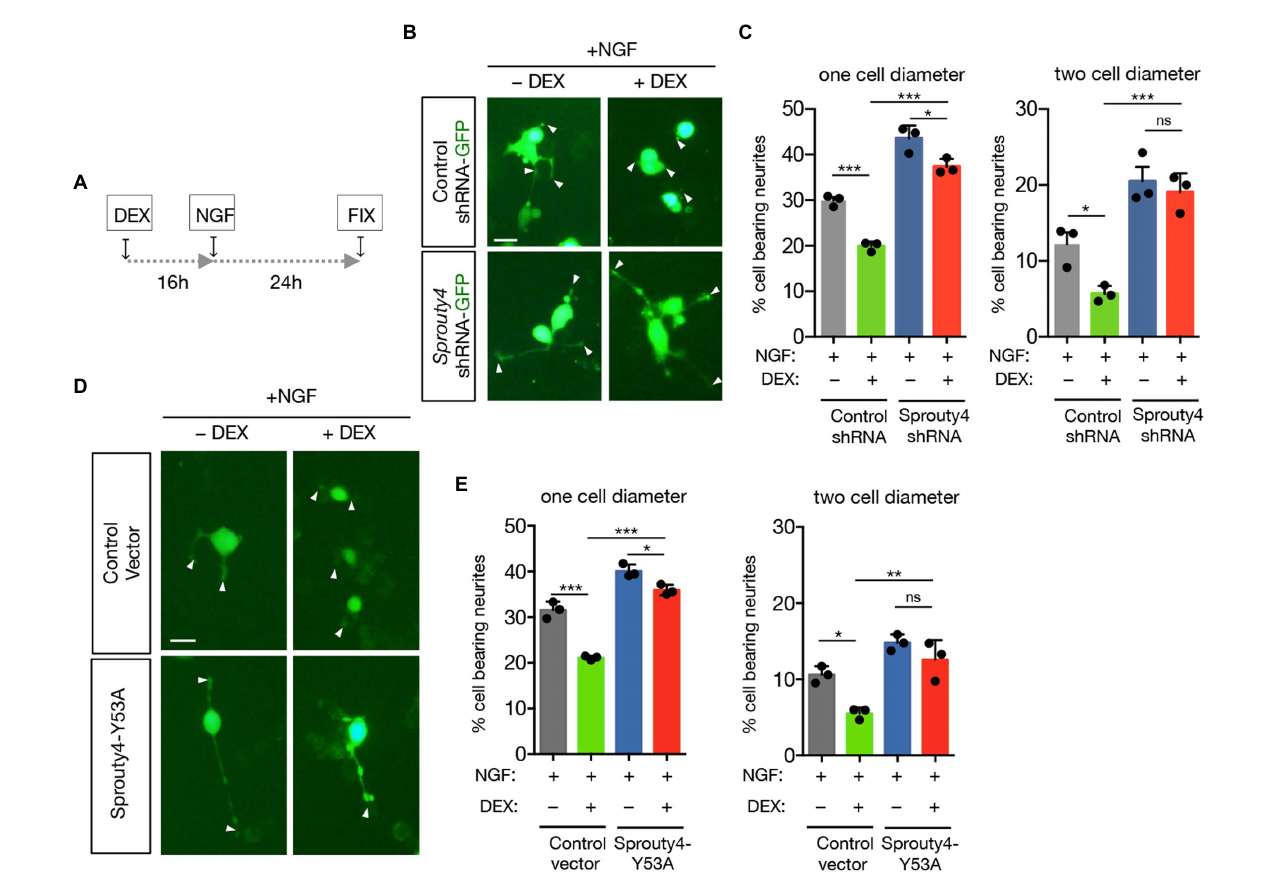
FIGURE 3 Knockdown of Sprouty4 limits the inhibitory effect of DEX on neurite outgrowth induced by NGF. (A) Experimental schedule of DEX and NGF treatment for PC12 neurite outgrowth. Fix means fixation. (B) Photomicrographs show PC12 cells transfected with control-shRNA-GFP or Sprouty4 -shRNA-GFP constructs and pretreated or not with DEX (1 μ M) and stimulated for 24 h with NGF (50 ng/mL). Arrowheads indicate neurite tips. Scale bar, 20 μ m. (C) Graph shows neurite outgrowth of PC12 cells transfected with control-shRNA or Sprouty4 -shRNA plasmids and pretreated or not with DEX and stimulated for 24 h with NGF. Quantification of the % of GFP-positive cells bearing neurites longer than one or two cell body diameter in the different experimental groups. For each experimental condition we quantified 120 images with approximately 15 to 20 cells per picture. Data are mean ± SD of n = 3 independent experiments. * p < 0.05, *** p < 0.001 by one-way ANOVA followed by Tukey’s multiple comparisons test. ns, not significant. (D) Photomicrographs show PC12 cells transfected with control or Sprouty4-Y53A constructs together with a GFP-expression vector and pretreated or not with DEX (1 μ M) and then stimulated for 24 h with NGF (50 ng/mL). Arrowheads indicate neurite tips. Scale bar, 20 μ m. (E) Graph shows neurite outgrowth of PC12 cells transfected with control or Sprouty4-Y53A constructs together with a GFP-expression vector and pretreated or not with DEX (1 μ M) and then stimulated for 24 h with NGF (50 ng/mL). Quantification of the % of GFP-positive cells bearing neurites longer than one or two cell body diameters in the different experimental groups. For each experimental condition we quantified 120 images with approximately 15 to 20 cells per picture. Data are mean ± SD of n = 3 independent experiments. * p < 0.05, ** p < 0.01, and *** p < 0.001 by one-way ANOVA followed by Tukey’s multiple comparisons test. ns, not